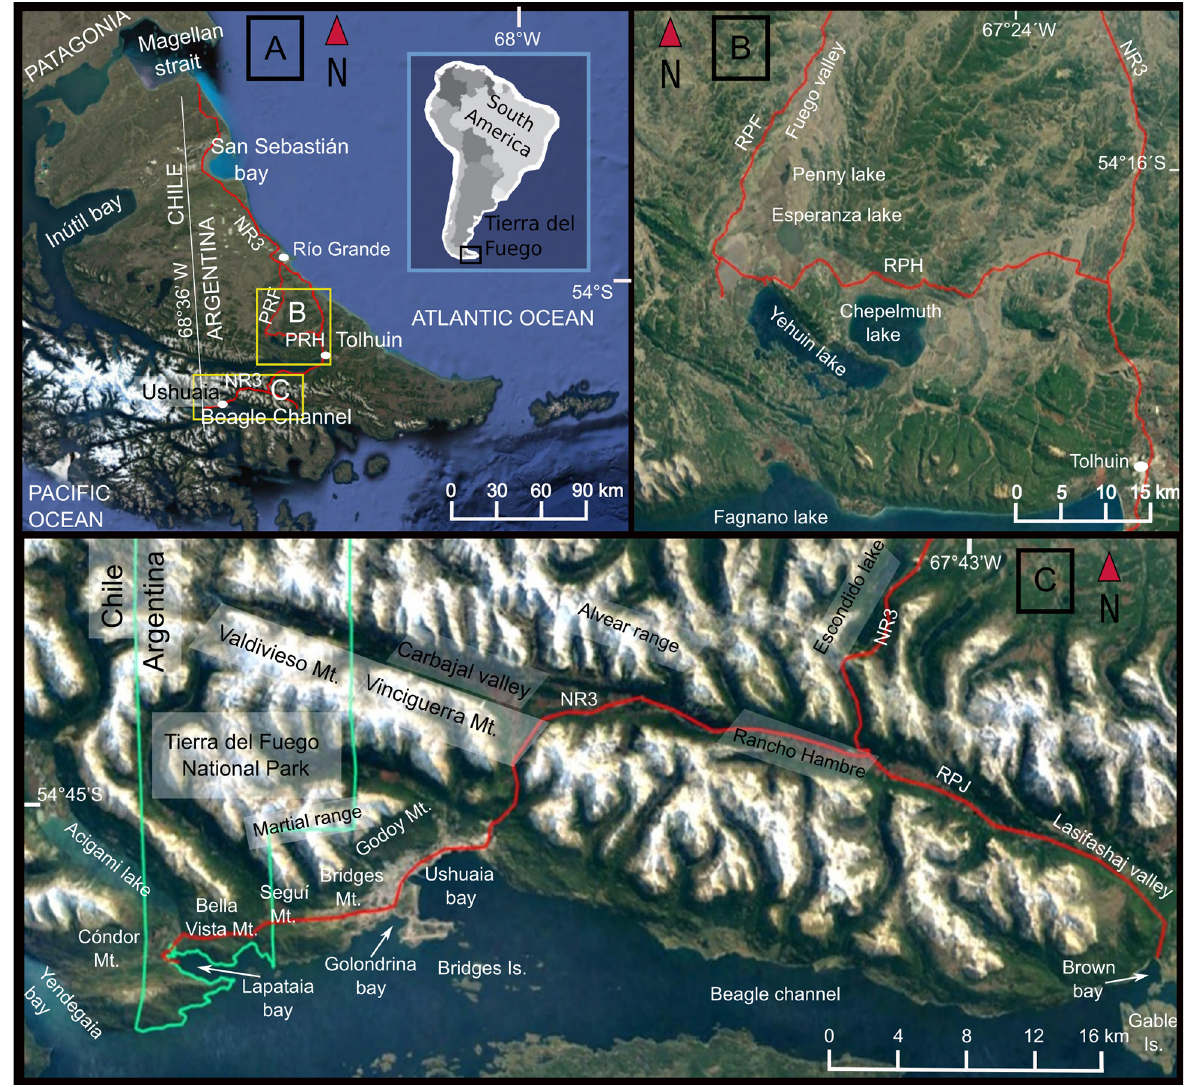
Fig. 1. Isla Grande de Tierra del Fuego map. A – points indicate the cities’ location; B – view of a sector of central Tierra del Fuego, where several described landforms are present; C – view of a sector of southern Tierra del Fuego, where most of the landforms are present. The three maps are based on Google Earth™ images. National Route Number 3 (NR3), the main paved road, communicates the territory mainly in the N–S direction. The others are dirty and provincial routes “H”, (RPH), “F” (RPF) and “J”